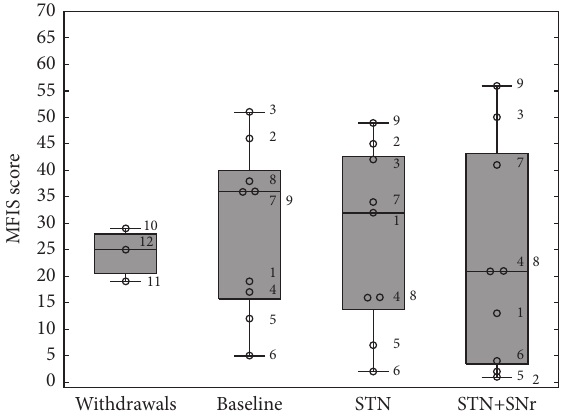
−36 Figure 4: Boxplots of LARS scores: the box plot depicted on the left represents the baseline values of the three patients who withdrew. The other three box plots represent the values of the 9 PD patients who have completed the study at the three experimental time points: (1) baseline, (2) STN alone, and (3) combined STN+SNr-DBS. The numbered circles represent the single patients as listed in Table 1. The dashed horizontal lines represent the cut-offs as previously described.